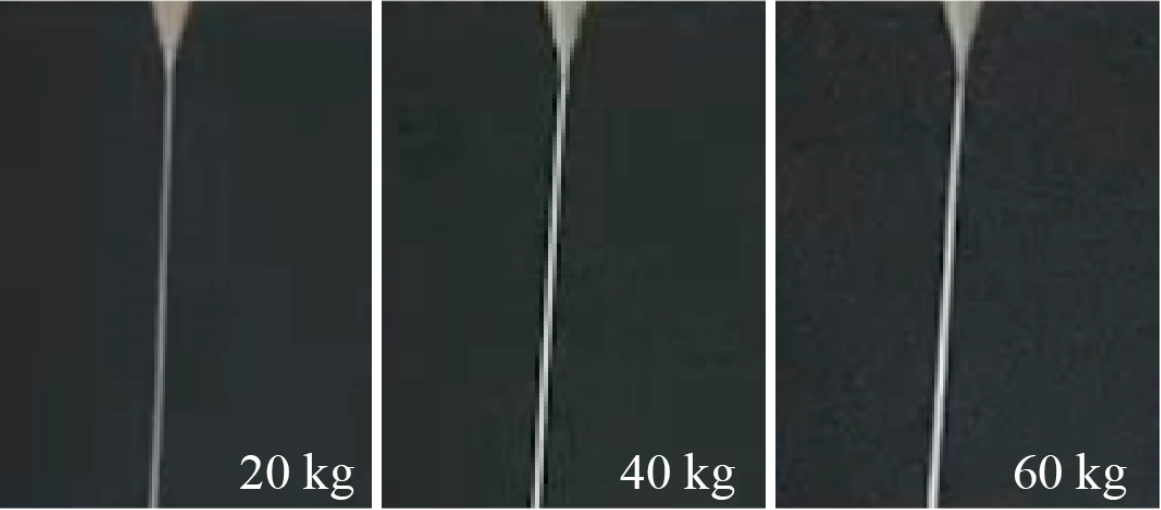
Figure 6. Images of the printing filaments at 100 °C.